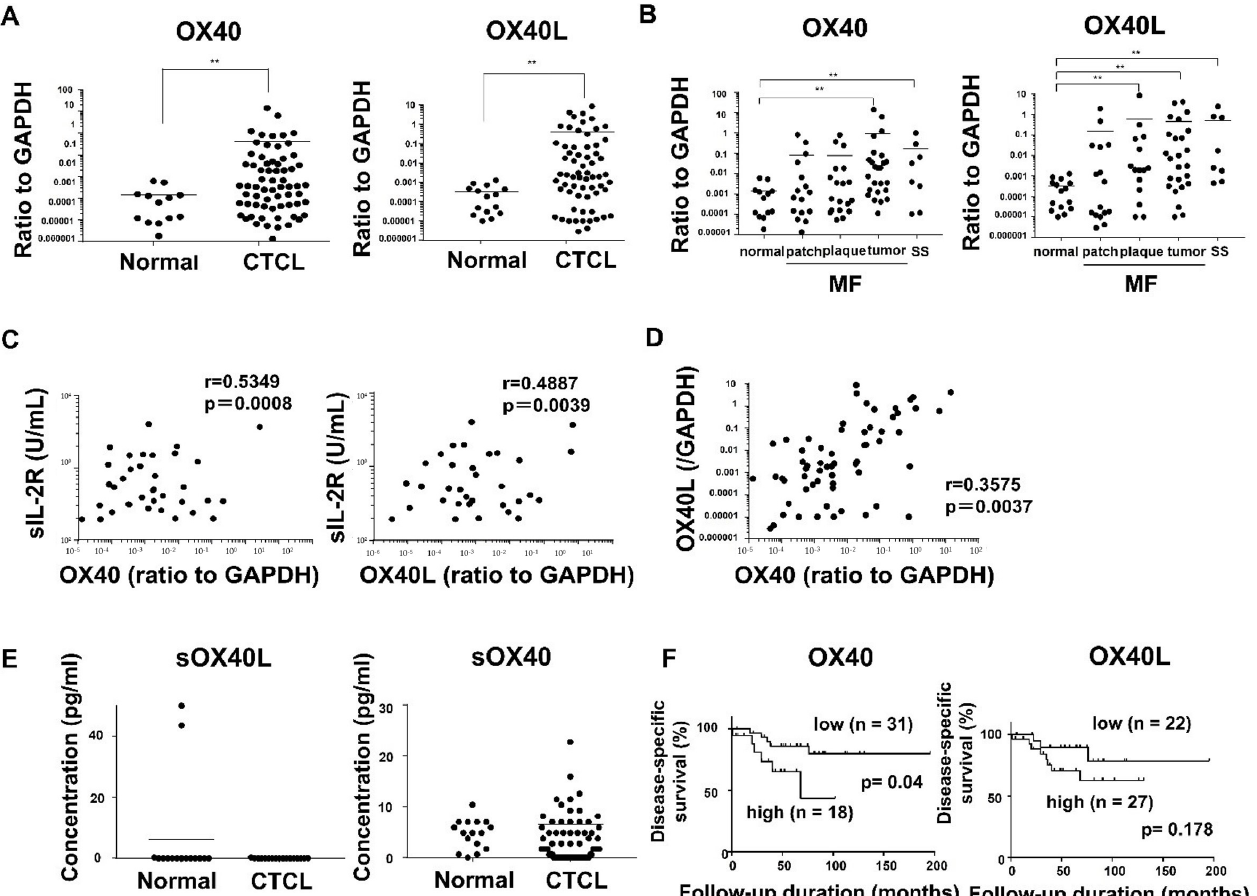
Figure 1. OX40 and OX40 ligand (OX40L) expression in patients with cutaneous T-cell lymphoma (CTCL). ( A , B ) Quantitative RT-PCR was performed to measure expression levels of OX40 and OX40L using mRNA extracted from MF/SS lesional skin ( n = 57; 49 MF cases and 8 SS cases) and normal skin ( n = 13). ( C ) Correlations between soluble IL-2 receptor (sIL-2R) and OX40 or OX40L mRNA expression in MF/SS patients. ( D ) Positive correlations between OX40 and OX40L mRNA expression in MF/SS lesional skin. ( E ) Serum soluble OX40 and soluble OX40L levels in CTCL patients. ( F ) MF/SS patients with high OX40 mRNA expression exhibited poor prognosis. Means are presented as bars. ** p <